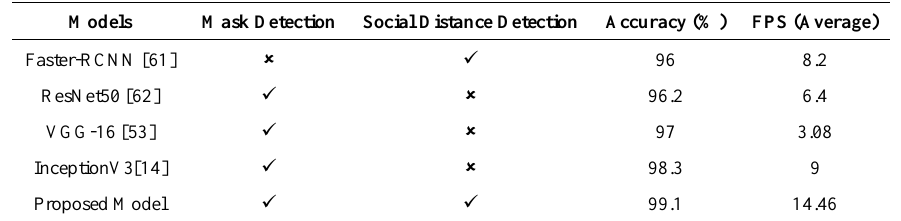
Table 5. Accuracy and Performance Comparison.